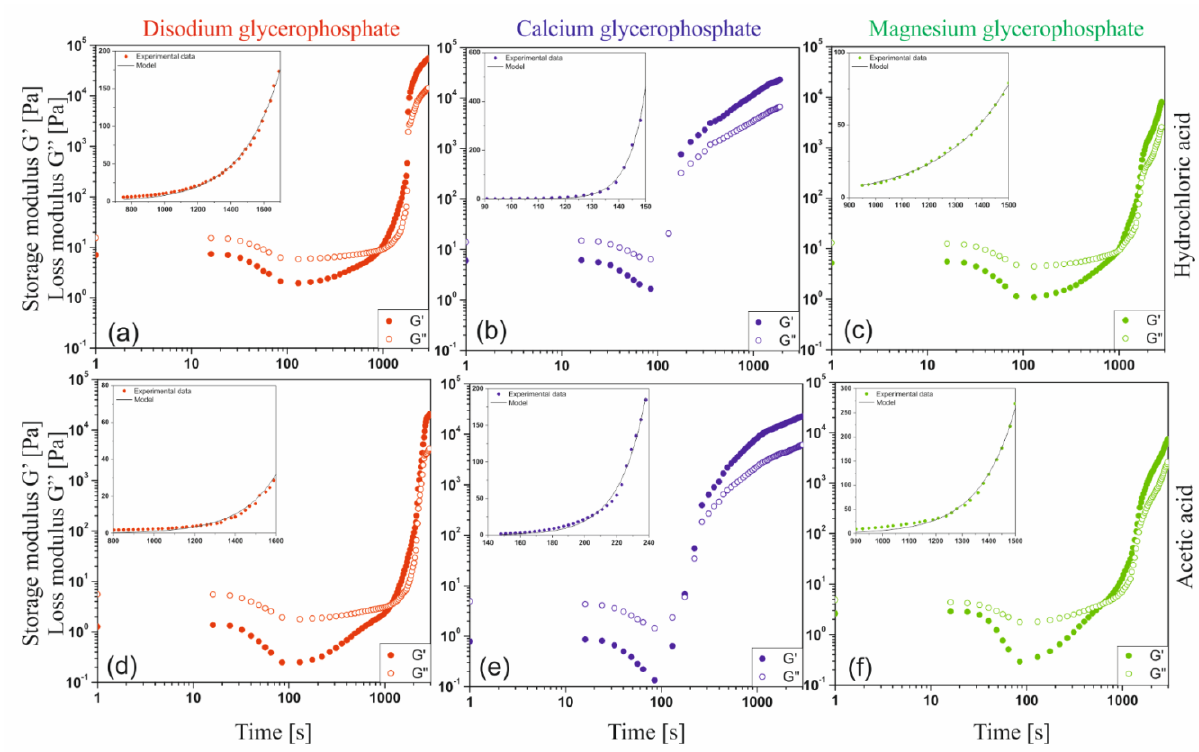
Figure 11. Experimental curves of changes in the values of the storage G’ and loss G” moduli obtained during isothermal measurements at 37 ◦ C for chloride ( a – c ) and acetate ( d – f ) chitosan solutions containing sodium glycerophosphate, calcium glycerophosphate, and magnesium glycerophosphate.